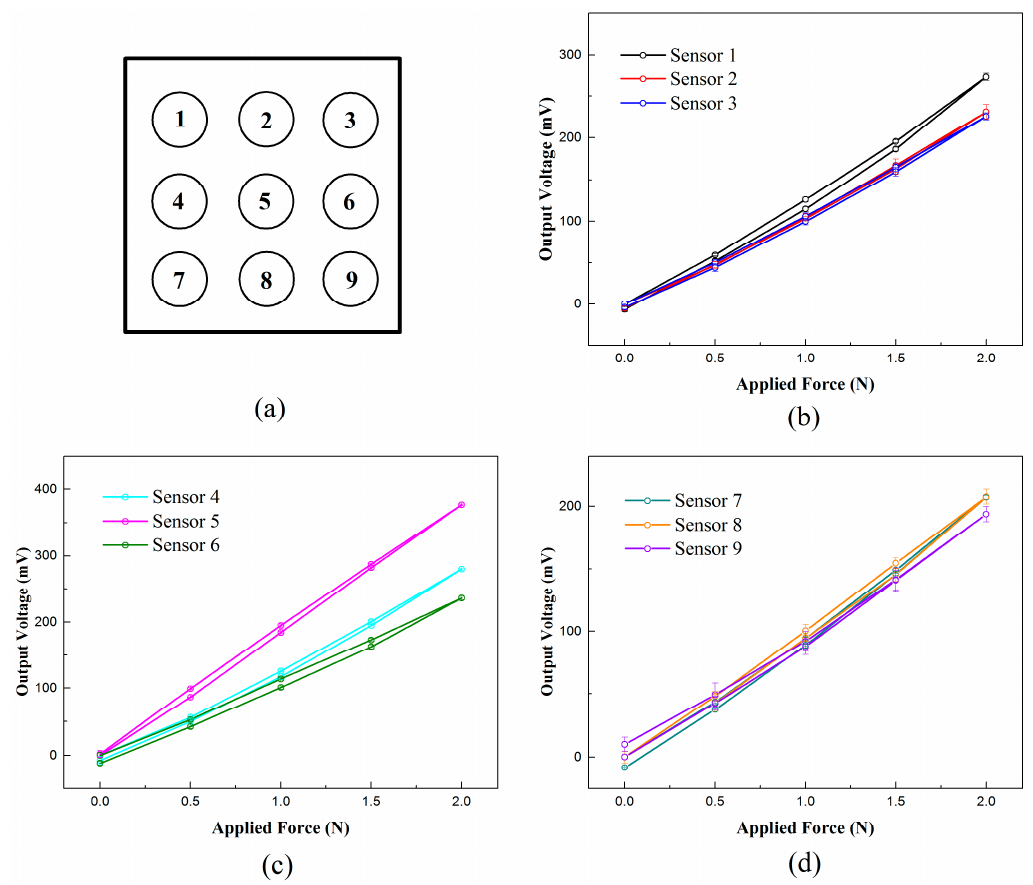
Figure 8. Relationships between the output voltage and the applied force for each sensor unit: ( a ) The schematic of the locations of the numbered sensor units in the sensor array; and the test results for the sensor: ( b ) 1–3; ( c ) 4–6; and ( d ) 7–9. Table 1. Repeatability error and hysteresis error of the sensor units.